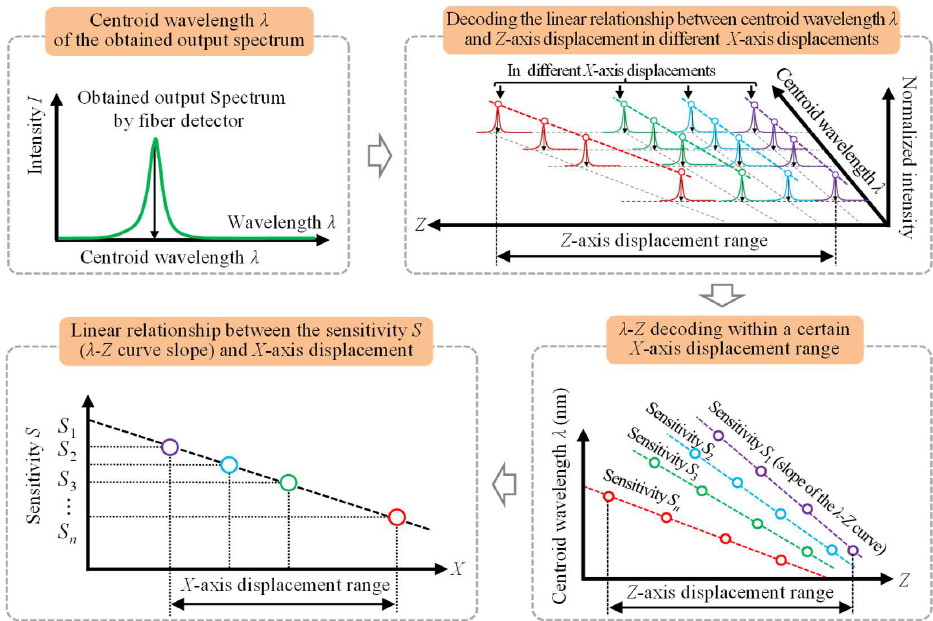
Figure 4. A flowchart of the measurement principle and the corresponding decoding process of the proposed fiber-based chromatic dispersion probe for displacement measurement of the Z -axis.